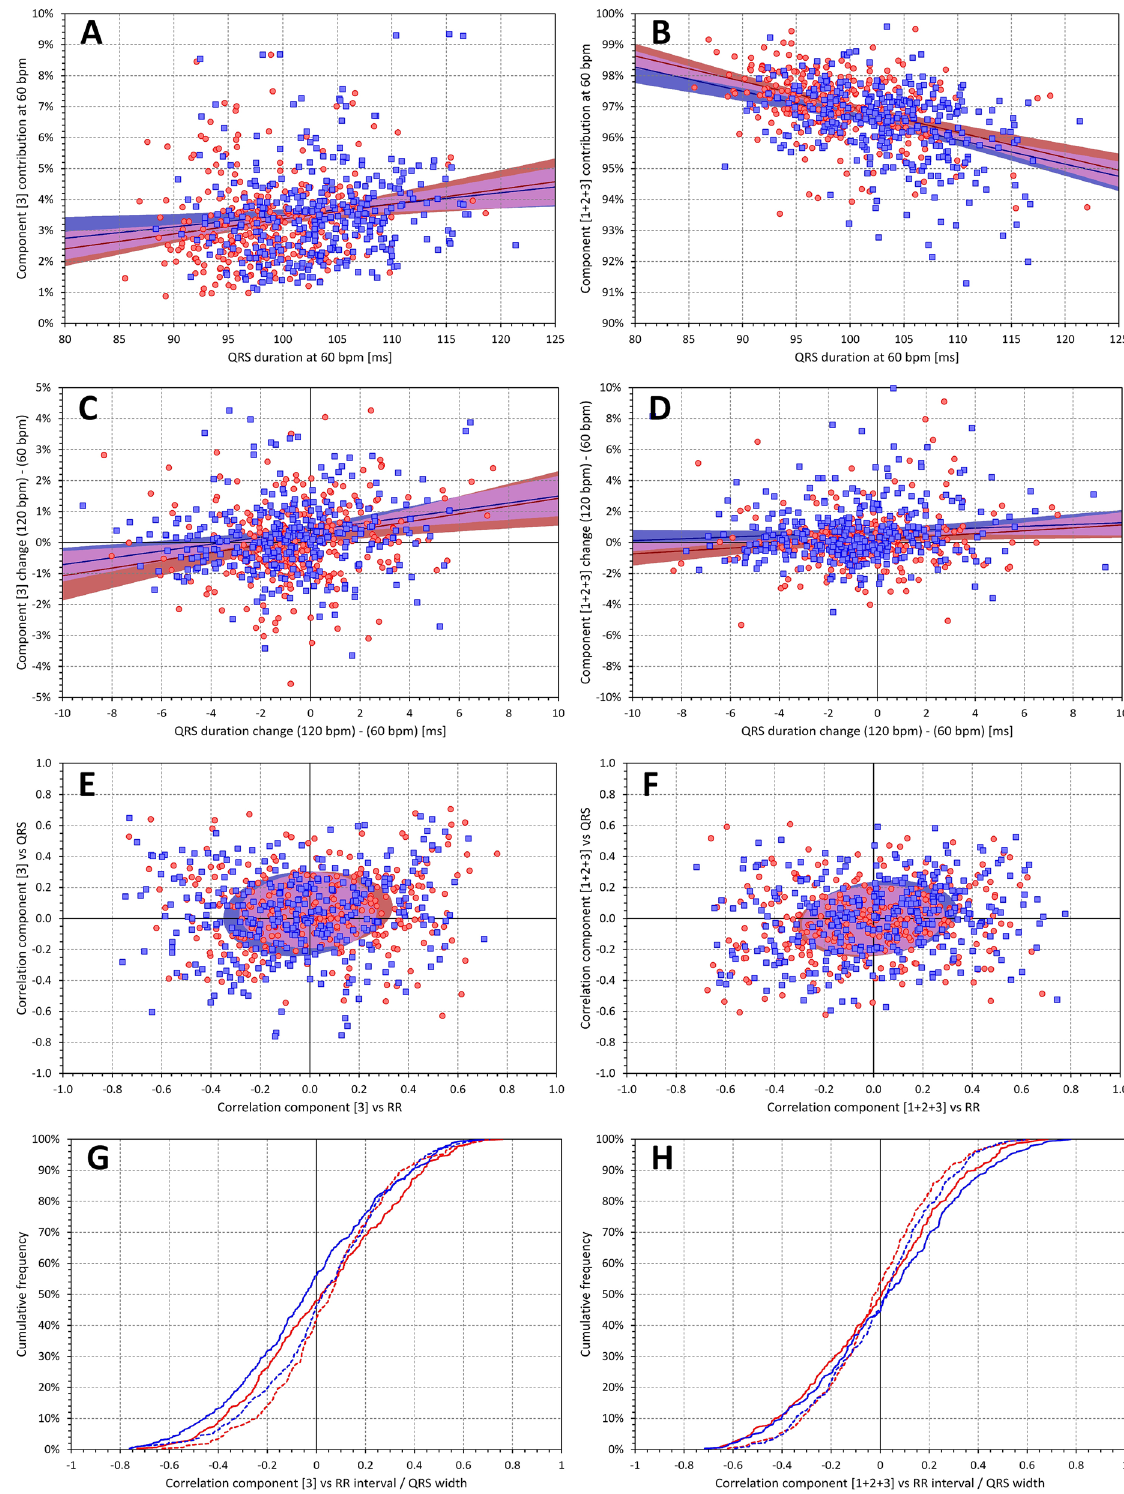
Figure 8. The layout and meaning of panels of the figure is the same as in Fig. 7. The left panels ( A ), ( C ), ( E ), and ( G ) correspond to the component ∇ 3 , whilst the right panels ( B ), ( D ), ( F ), and ( H ) correspond to the combination of components ∇ 1 + ∇ 2 + ∇ 3